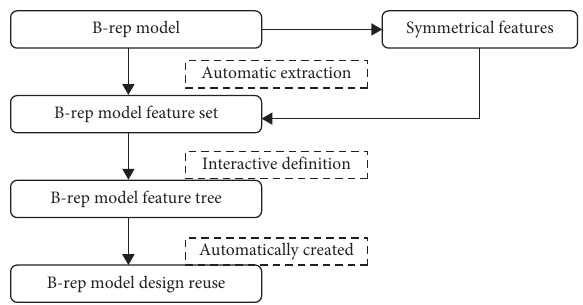
Figure 1: Flow chart of modern art interactive design and evaluation